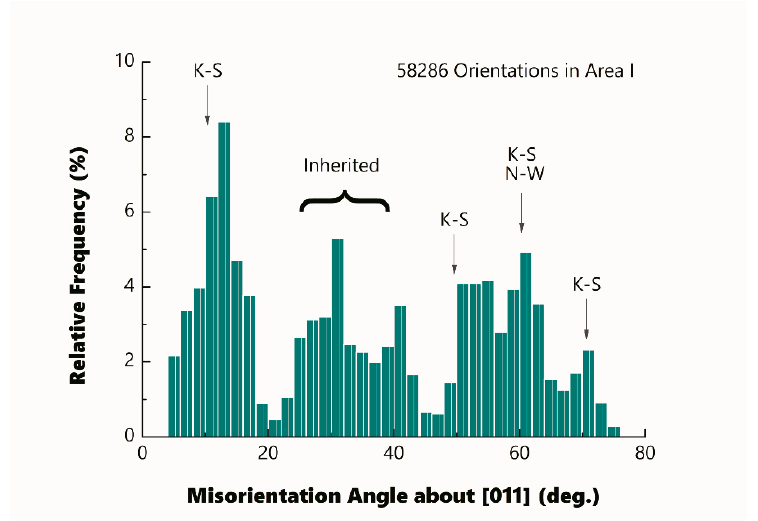
Figure 4. Experimental distribution of misorientation angles about [011] axis between neighboring variants in Area I. K–S indicates Kurdjumov–Sachs, and N–W Nishiyama–Wassermann orientation relationships, respectively.